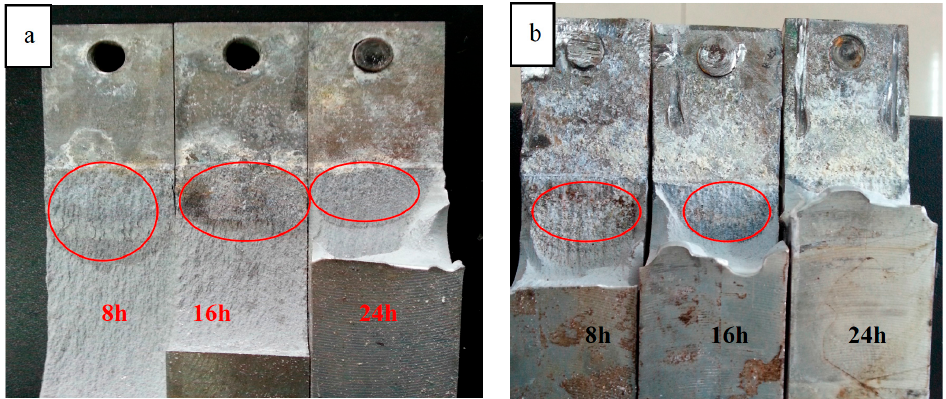
Figure 3. Fracture photos of AA7050 DCB specimens. ( a ) With a cathodic potential of − 1100 mV; ( b ) without any cathodic potential.